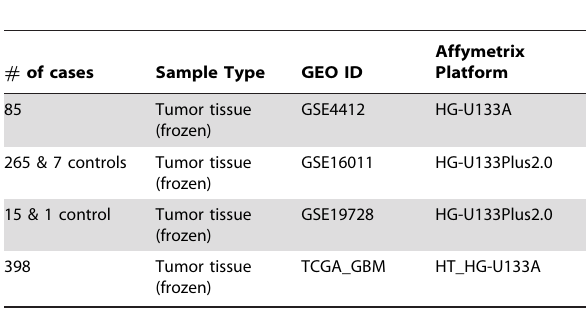
Table 1. Independent glioma RNA expression microarray datasets.